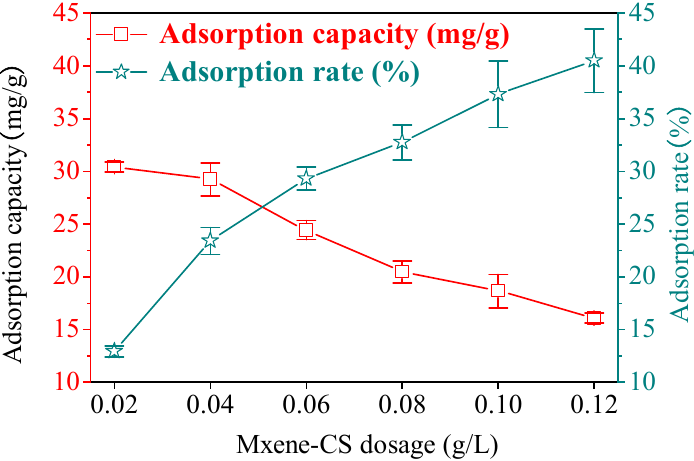
Figure 4. Effect of Mxene–CS dosage on the adsorption capacity and rate of Cr(VI) (Conditions: Adsorption temperature of 25 °C, pH of 4.3, and reaction time of 24 h).